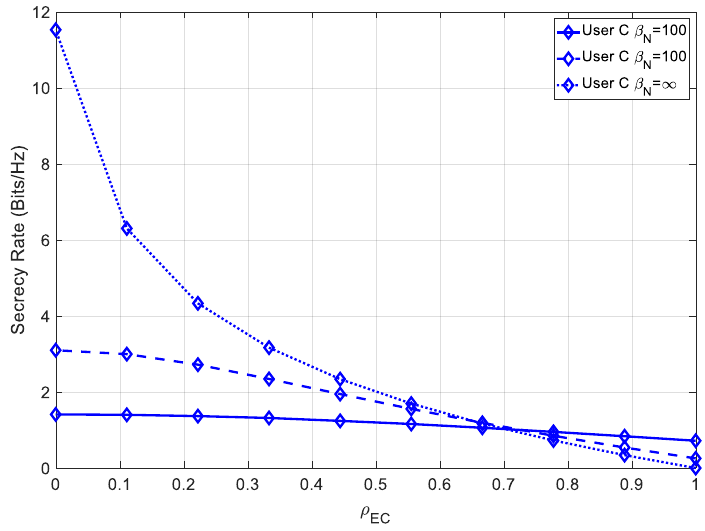
Figure 11. Secrecy rate of the 8 × 8 receiver C with different channel estimation